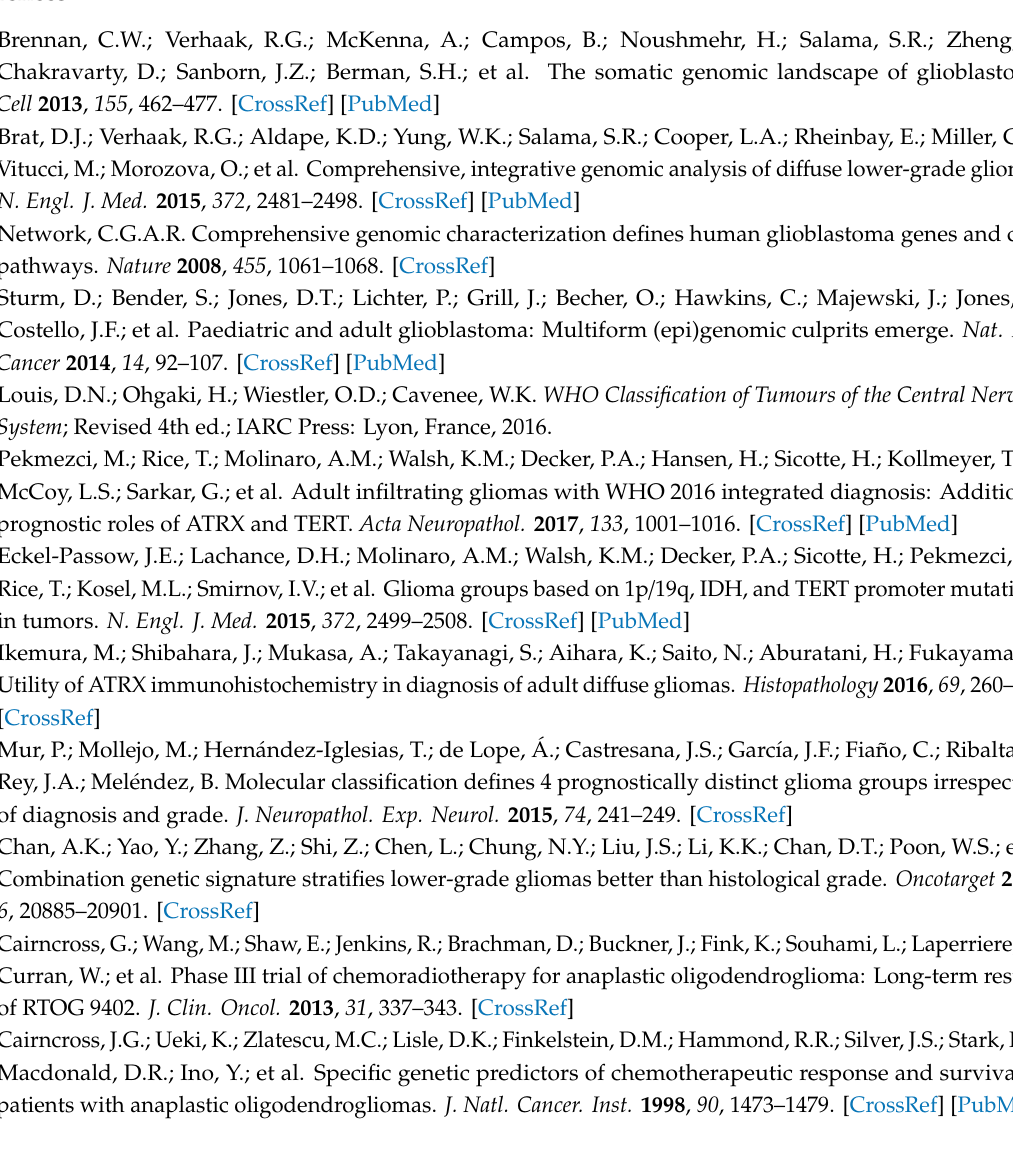
Figure S1: Graphical representation of the mean depth, mapped reads, and uniformity obtained for the NGS assays; Figure S2: Visualization using Integrative Genomic Viewer of the AcroMetrix engineered DNA and a PTEN mutant sample; Figure S3: Comparative analyses of the allelic frequencies obtained with the cancer hotspot and glioma NGS panels. Table S1: Validation of the NGS-1p / 19q codeletion detection by FISH; Table S2: Summary of samples and patients included in the study. Table S3: SNPs used in the 1p / 19q LOH